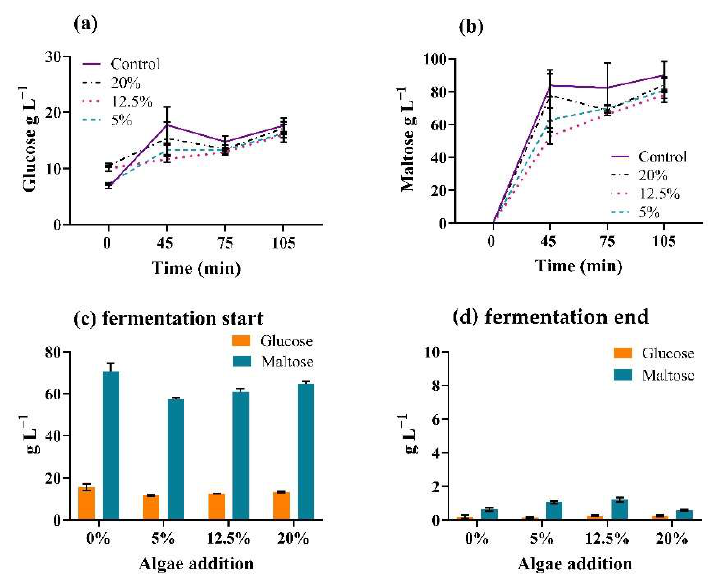
Figure 5. Mashing and fermentation sugar content during brewing trials with T. chui . ( a ) Glucose and ( b ) maltose detection during progression of one-step mashing at 67 ◦ C; ( c ) fermentable sugar detection on the first and ( d ) last day of fermentation. All values represent mean ± SD of triplicate